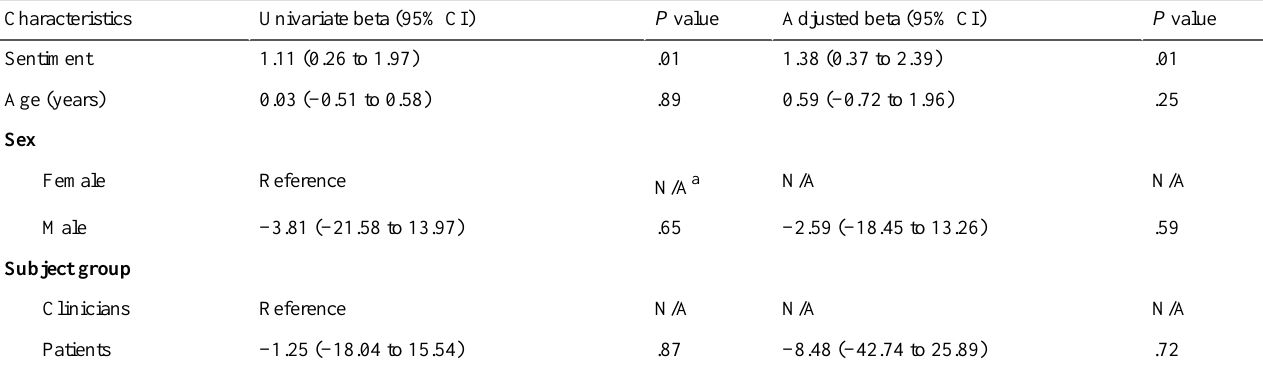
Table 2. Univariate and adjusted model for the System Usability Scale score with